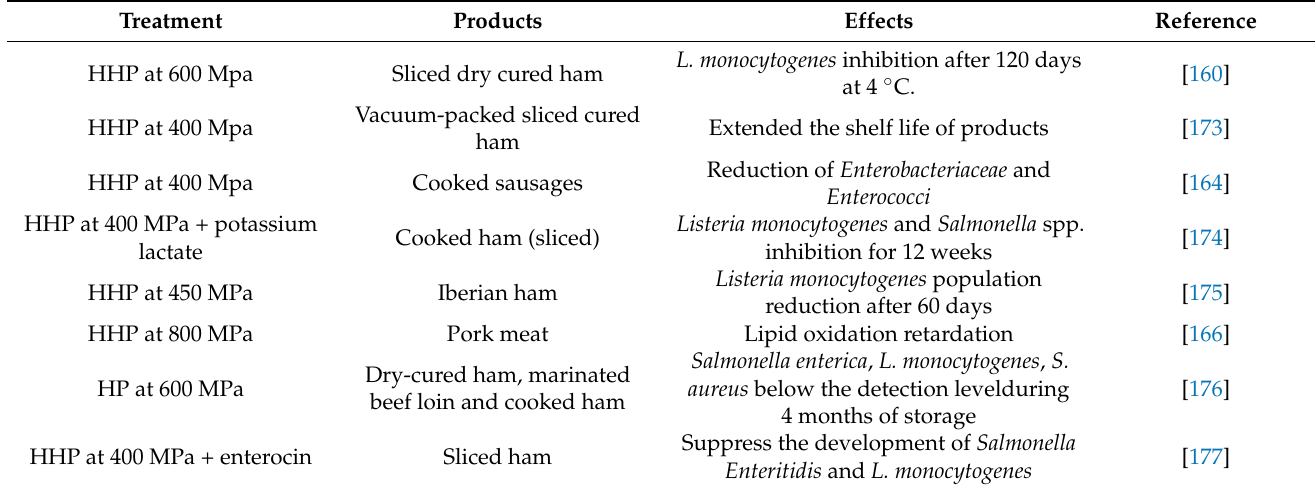
Table 2. Uses of different HHP treatments and their effect on various meat